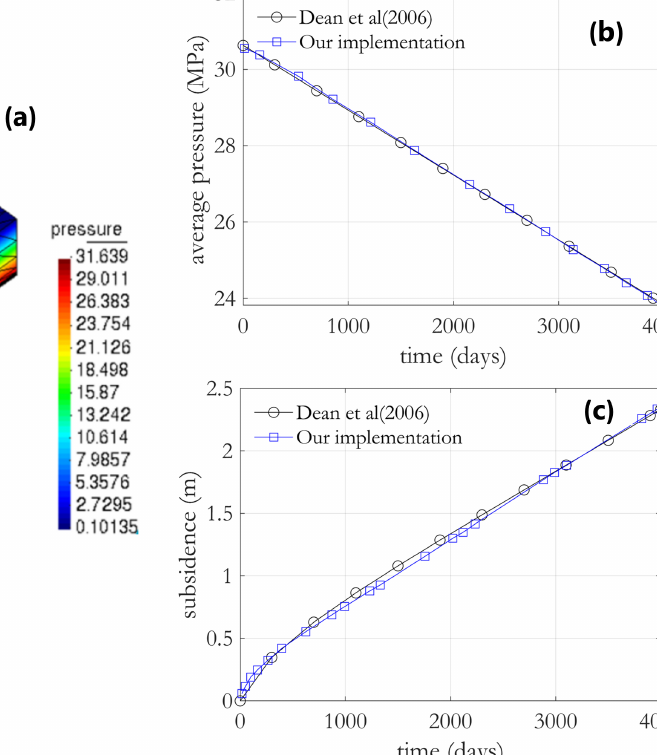
Figure 8. (a) Pressure profile in the reservoir, (b) mean pressure (c) compaction of the